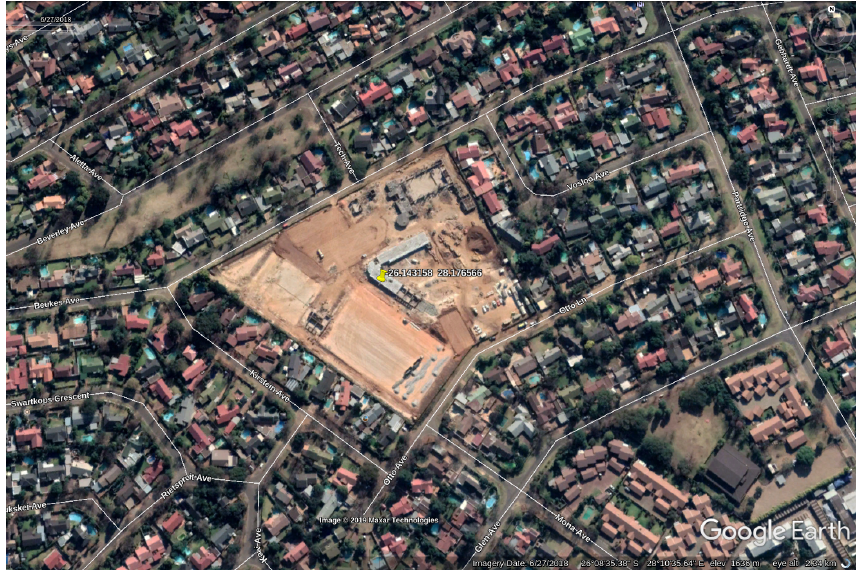
Figure 7. Google Earth image of a Germiston construction site.